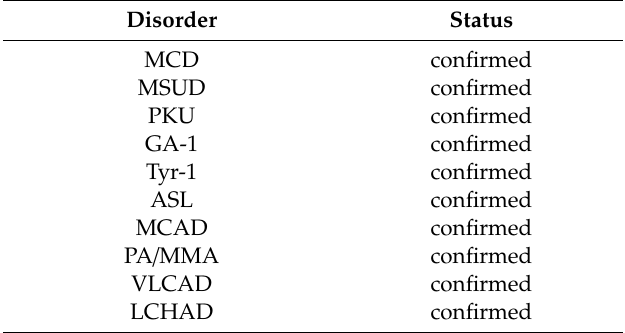
Table A1. Results of samples with other disorder that we run using the TMS